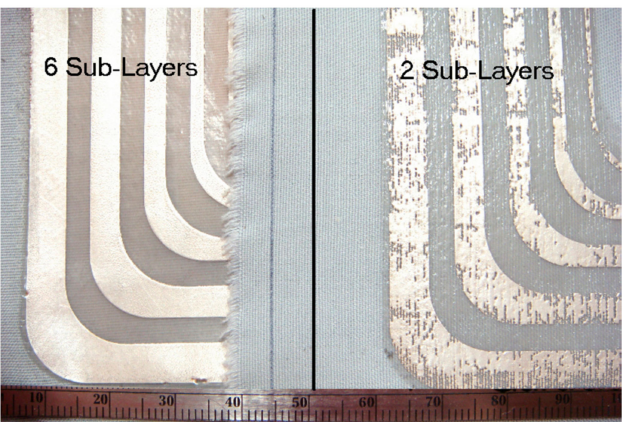
Figure 4. Roughness of interface layer comparison. Demo tracks printed on a smooth surface of the interface with 6 sub-layers on the left side, and a rough surface of the interface with 2 sub-layers on the right